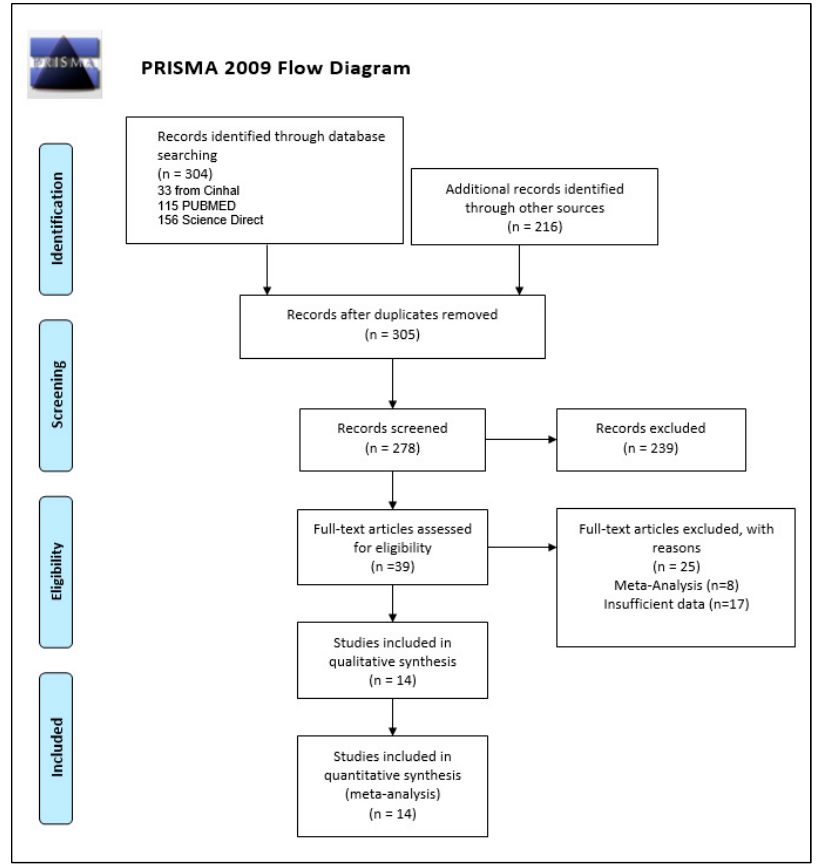
Figure 1. Prisma flow diagram.